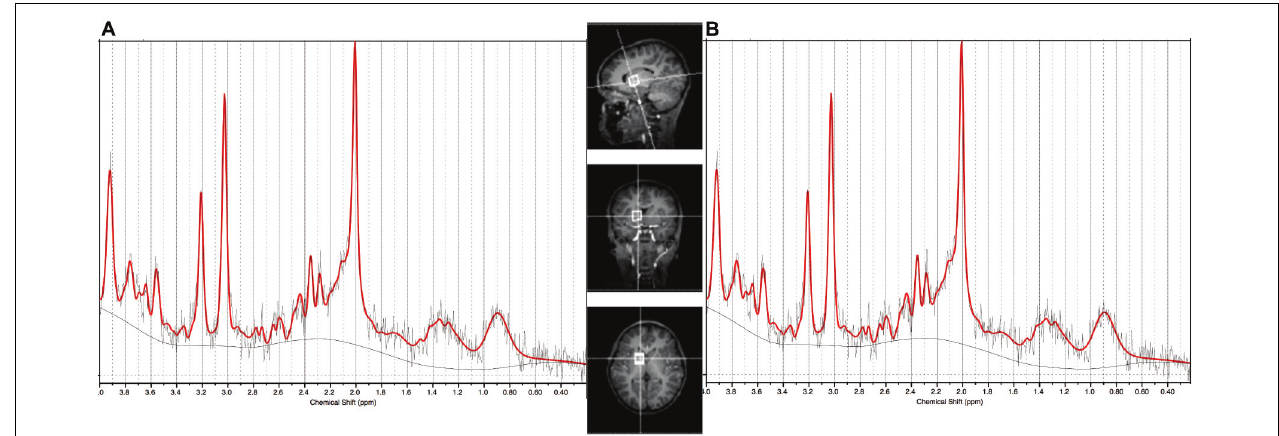
FIGURE 1 | Sample spectrum of median SNR and LCModel output from (A) the Allegra scanner used for the 7 year olds (SNR = 8) and (B) the Skyra scanner used for the 9 year olds (SNR = 14). Basal ganglia voxel placement shown in center panel.